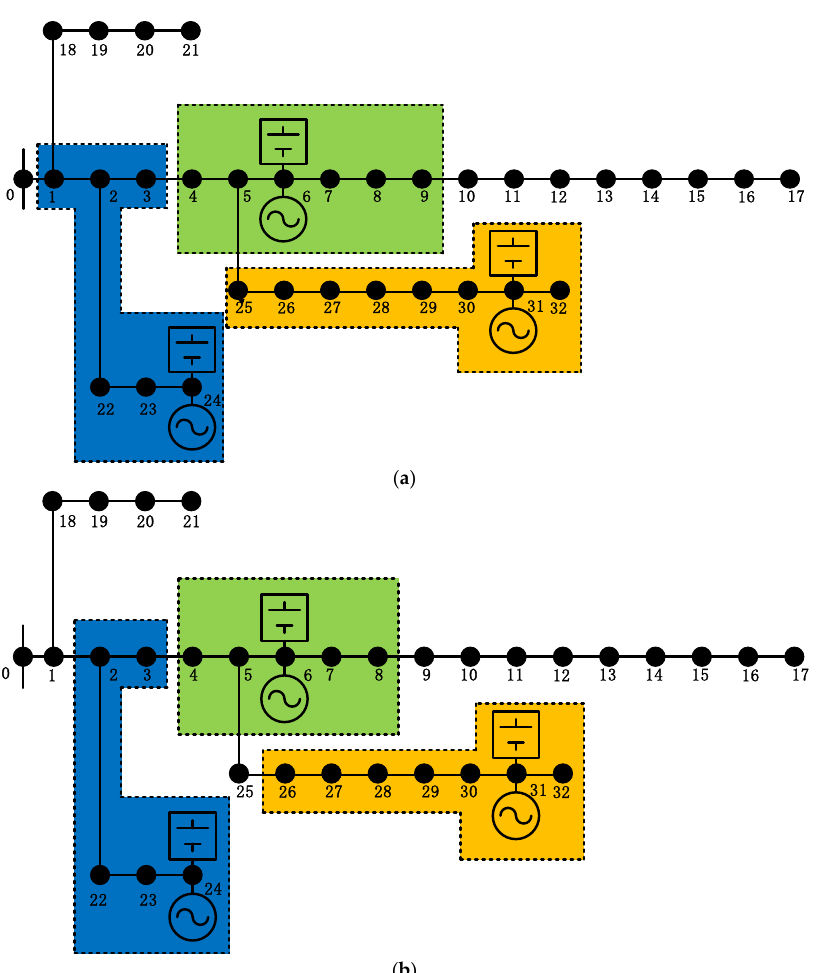
Figure 2. ( a ) Island division scheme 1 considering the static boundary; ( b ) island division scheme 2 considering the dynamic boundary island division. considering the dynamic boundary island